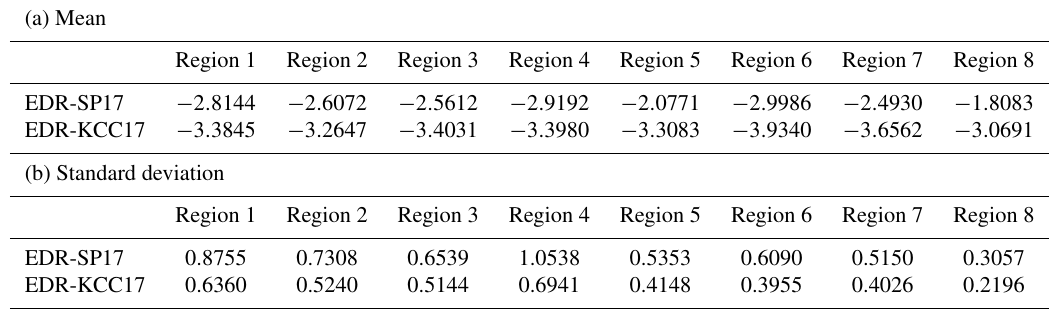
Table 1. Values of the mean and standard deviation (SD) of the natural logarithms of EDR-SP17 and EDR-KCC17, over the eight selected regions indicated in Fig. 8, from October 2015 to September 2018. The unit is m 2 / 3 s − 1 . Note that EDR-SP17 and EDR-KCC17 are the DEVG-derived EDRs obtained using the methods of Sharman and Pearson (2017) and Kim et al. (2017),